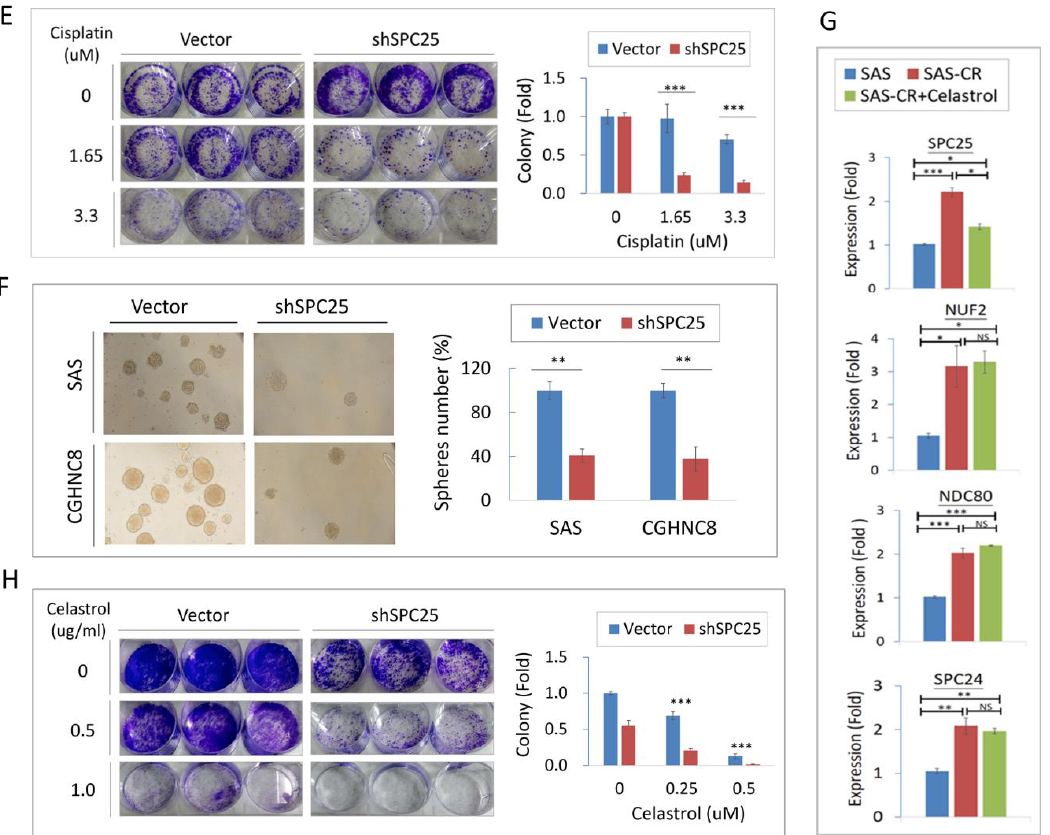
Figure 6. Silencing kinetochore protein spindle pole body component 25 (SPC25) contributes to cisplatin resistance. ( A ) Schematic diagram of the microtubule–kinetochore interface and NDC80 kinetochore complex proteins. ( B ) The expression level of NDC80 complex proteins (NDC80, NUF2, SPC24, and SCP25) in parental and CR cells as examined by RT-qPCR. ( C ) Reduction in SPC25 expression in SPC25-specific silencing cells. After transfection of SPC25-specific shRNA plasmids or the vectors, the stable transfected cells were selected by using G418. The efficiency of SPC25 silencing was verified by the protein expression as determined by Western blotting. The level of GAPDH expression was used as an internal control to determine relative protein expression. The effect of SPC25 silencing (shSPC25) on the cisplatin sensitivity as determined using survival, as determined by ( D ) MTS survival, or ( E ) colony formation assays in SAS cells. ( F ) The effect of SPC25 silencing (shSPC25) on cancer stemness as determined by tumorsphere assay in SAS and CGHNC8 cells. ( G ) The specific effect of celastrol on the inhibition of SPC25 expression in SAS-CR cells. The SAS cells were treated with 0.5 μM c celastrol, and the gene expression level was performed by RT-qPCR. ( H ) Effect of growth suppression by celastrol and SPC25-silencing. The shSPC25 or the vector-transfected SAS cells were treated with various doses of celastrol, and cell colony formation was determined after 7 days. p -values indicate statistical significance (* p ≤ 0.05, ** p ≤ 0.01, *** p ≤ 0.001).